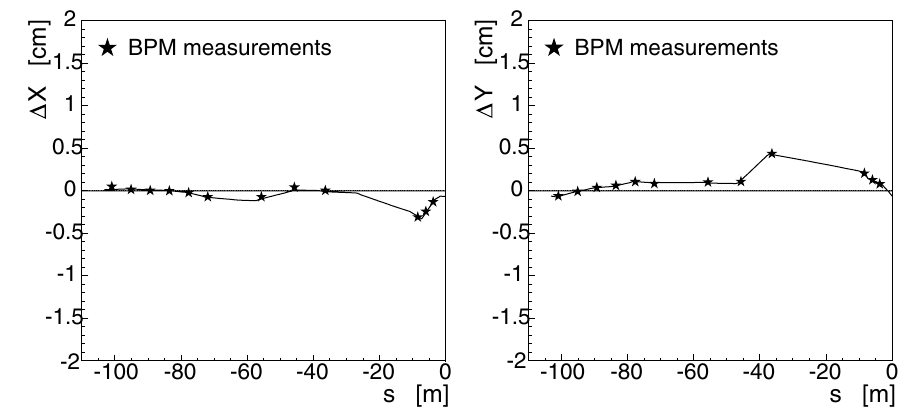
FIG. 2. Example of the orbit-fitting results after the offset corrections. The left (right) figure shows the horizontal (vertical) fitted orbit together with the BPM measurements. (cid:1) 2